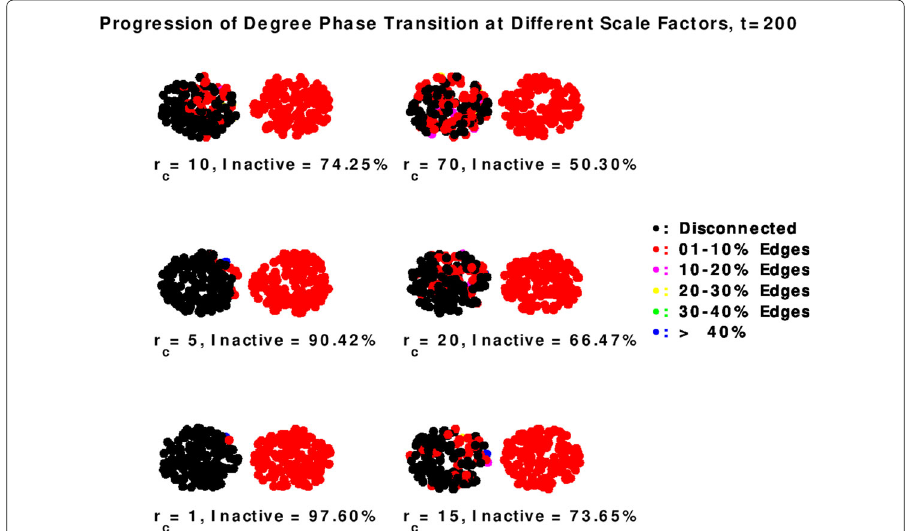
Fig. 6 A selection of samples from the graph with development arrested at t = 200. Each sample has a larger value of r c , gradually approaching δ s , at which point the phase transition occurs. The nodes are color coded against the percentage of links that they attract, and it is evident that as r c approaches 70 there is a transition to a more widespread interlinkage between the two node populations, whereas at small values of r c very few nodes in the left hand population capture all of the links and the nodes are not in widespread